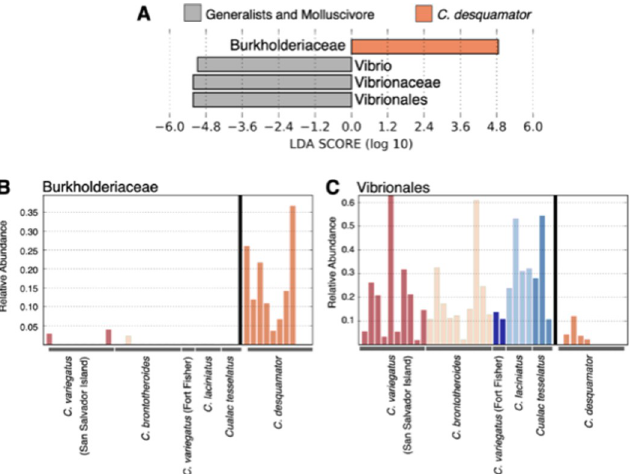
Fig 4. Linear discriminate analysis between Cyprinodon desquamator (scale-eater) and non-scale eaters. A) Log scores of the top four dominant loadings on LEFSE discriminate axis separating scale-eaters from all other pupfish samples. B) Relative abundance of the family Burkholderiaceae and the order C) Vibrionales among all pupfish gut microbiomes.